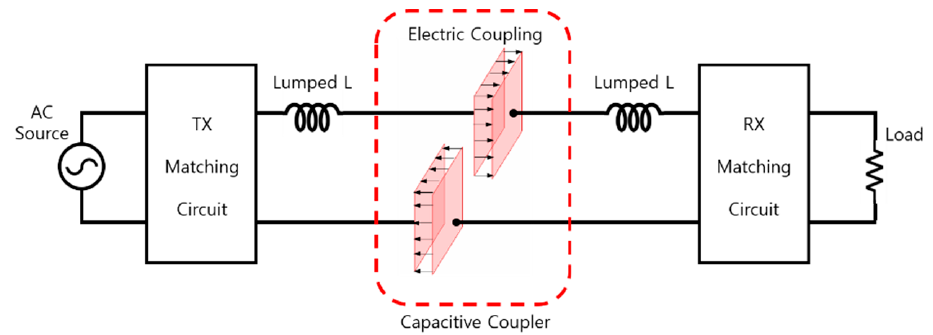
Figure 1. Block diagram of proposed ER-WPT system.